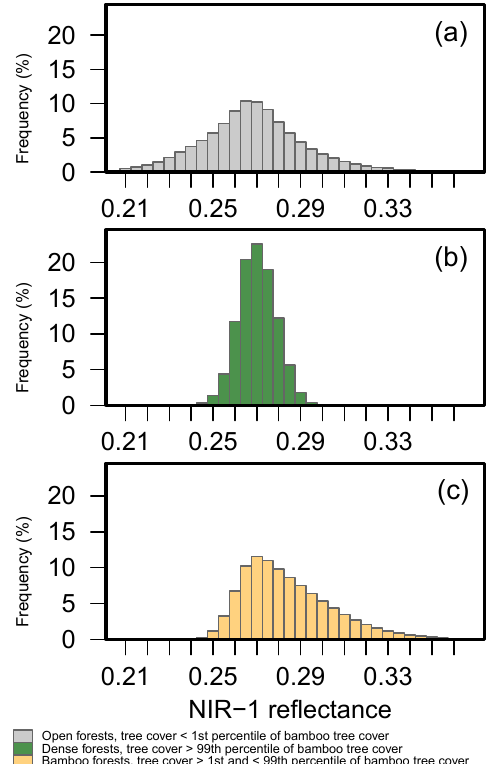
Figure 4. Relative frequency of MODIS NIR-1 reflectance (band 2) from pixels with tree cover percentage (a) below, (b) above and (c) within the 1st to 99th percentile range of tree cover found in bamboo-dominated forest (hatched in Fig. 3), as delineated by Car- valho et al.